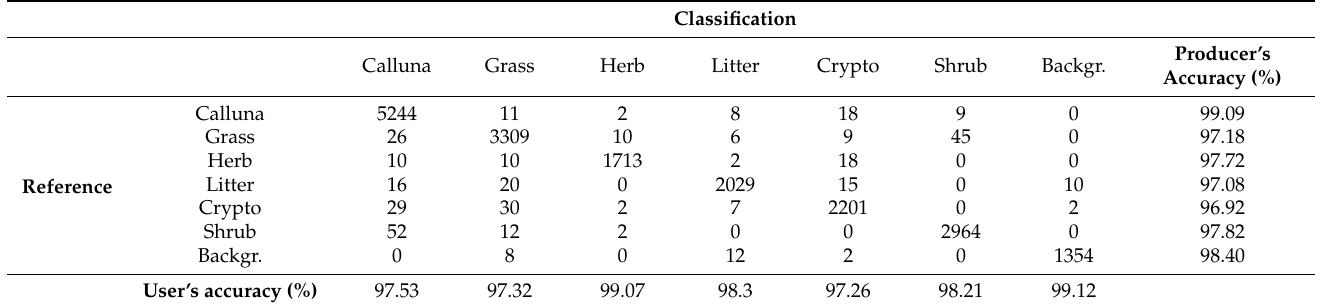
Table 4. After mowing classification result from random forest out-of-bag